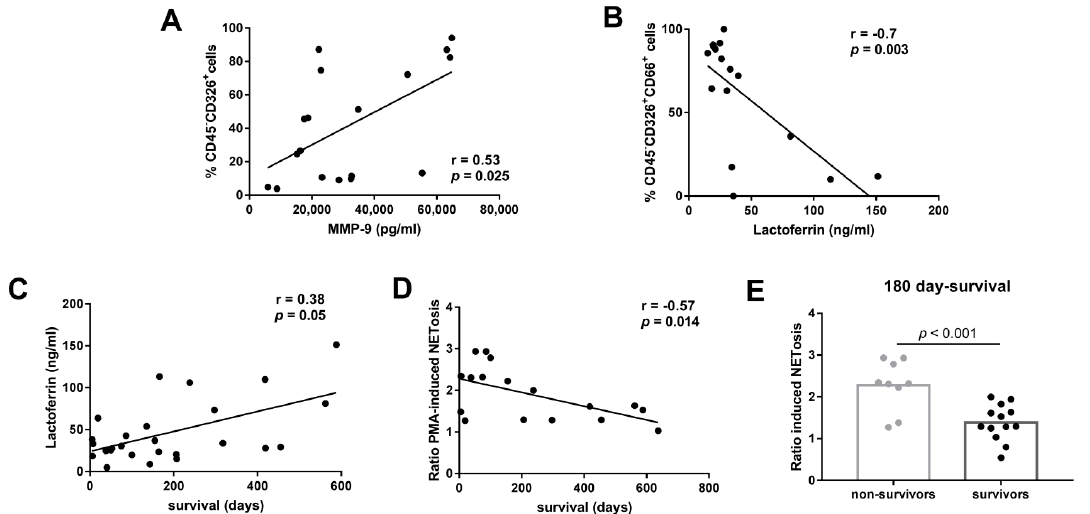
Figure 5. Association between pleural neutrophil-related factors and functions and LAC patient survival. Correlations between the percentage of tumor cells and pleural levels of ( A ) MMP-9 (pg/mL) and ( B ) lactoferrin (ng/mL). ( C ) Spearman positive correlation between pleural lactoferrin levels (ng/mL) and survival days after MPE diagnosis in LAC patients. ( D ) Pearson negative correlation between PMA-induced cf-PE NETosis and survival days after MPE diagnosis. ( E ) Comparison of 180-day survival of LAC patients based on the ability of their pleural fluids to induce NETosis. Correlation coefficients and p -values are presented in the graphs. The unpaired t -test was used for the statistical analysis of 180-day survival. NETosis-related data are expressed as ratios calculated by dividing LAC values by their respective medium